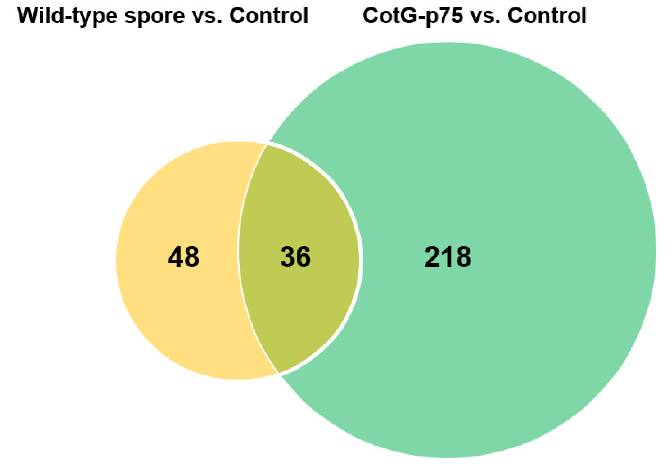
Figure 1. Volcano plot of differentially expressed genes (DEGs) in wild-type spores-stimulated cells versus control cells ( A ) and CotG-p75-stimulated cells versus control cells ( B ). Scattered yellow and blue dots indicate up-regulated and down-regulated DEGs with significant differences corresponding to an adjusted p -value < 0.05, respectively. Gray dots indicate non-differentially expressed genes.